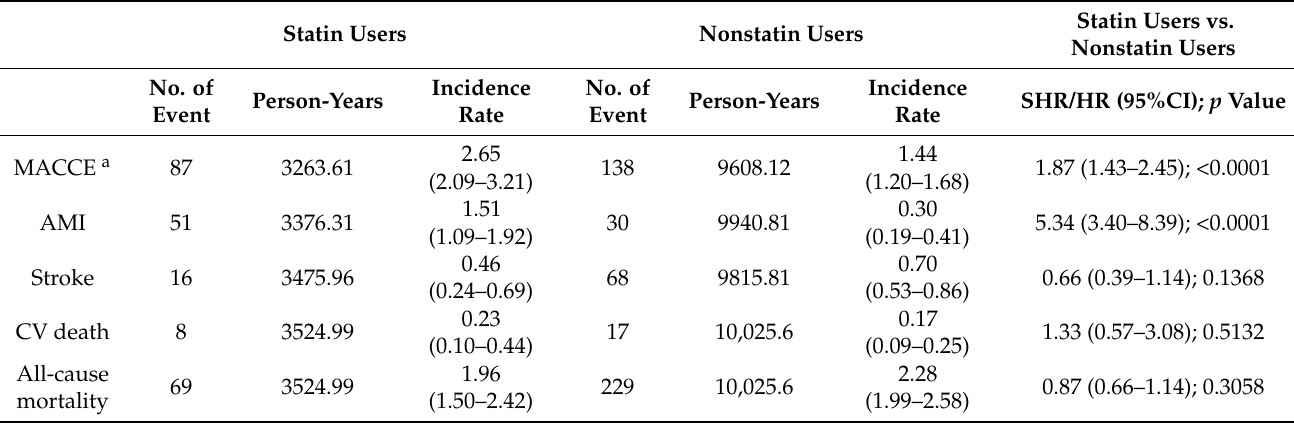
Table 2. Follow-up outcomes of young adult patients with ESRD according to their use of